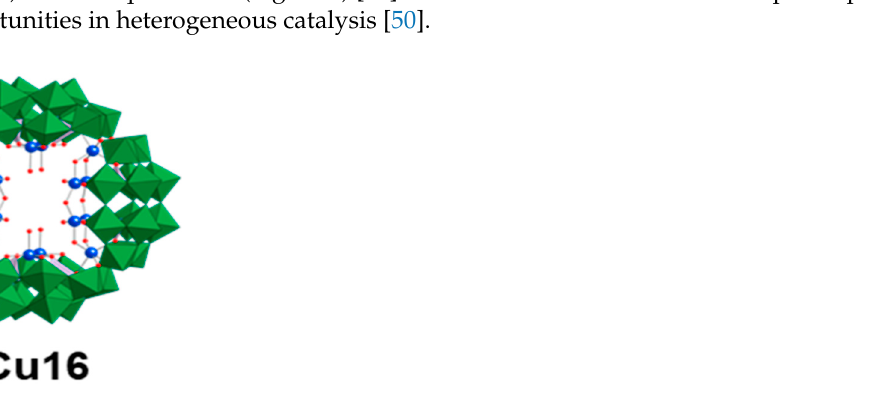
Figure 4. An example of an inorganic cavitin: multinuclear Cu-containing ring-shaped POM Cu16. Adapted with permission from (Koizumi et al., 2022) [49]. Copyright 2022 Wiley.